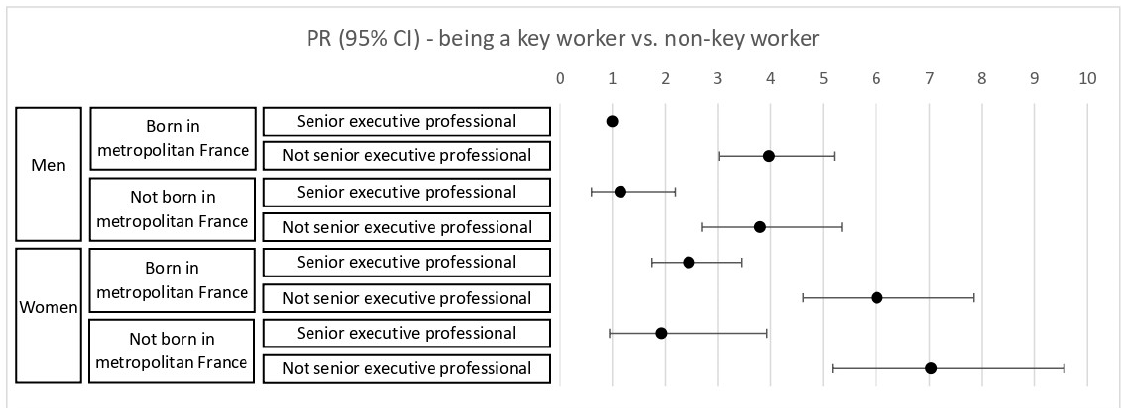
Figure 1. Estimated age-adjusted prevalence ratios (PR) for the association between intersecting socio-demographic characteristics (gender, origin, occupation) and working as a key worker. Looking at different subgroups of key workers, we found more contrasted profiles.